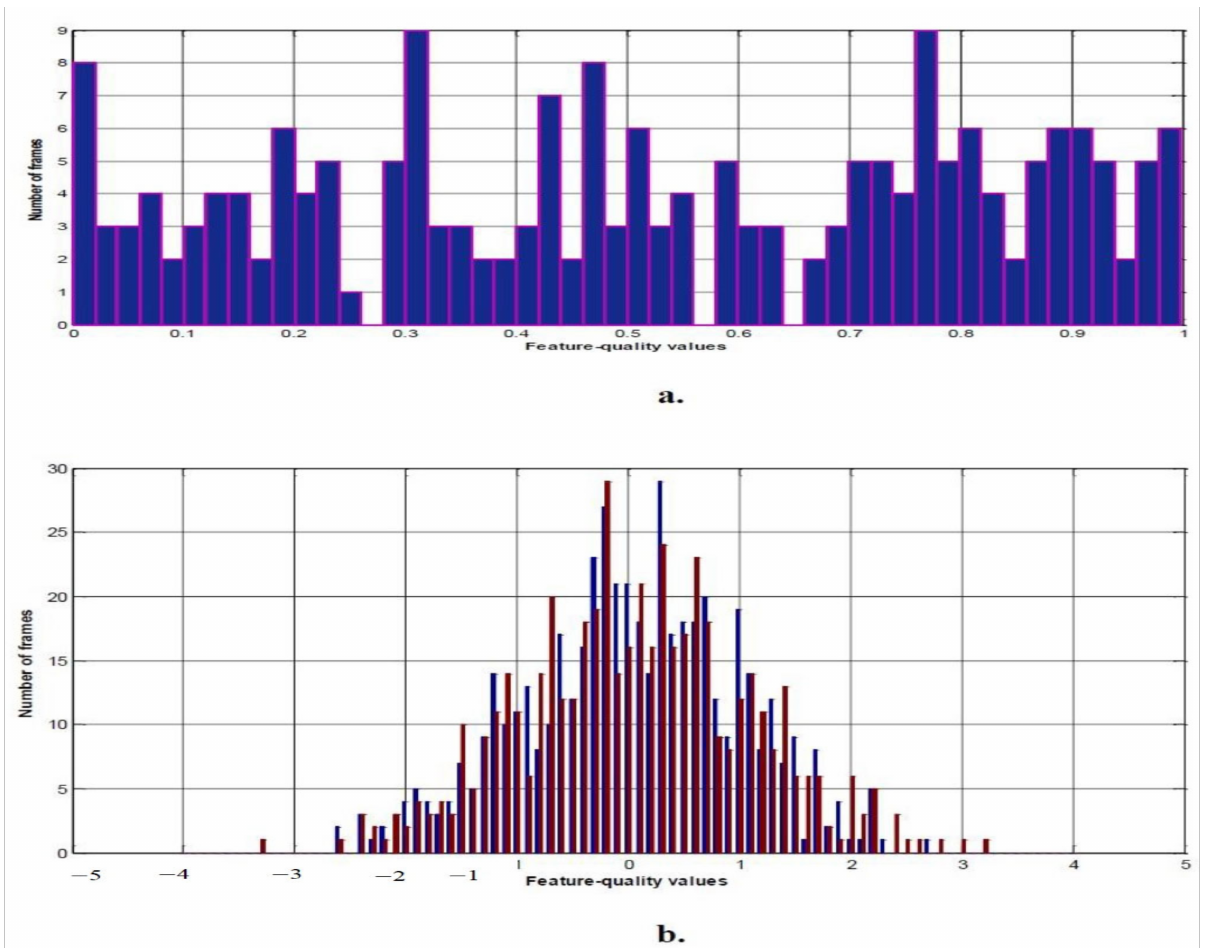
Figure 4. Feature distribution Feature distribution for two dissimilar videos ( a , b ) where some value reaches to zero where as some feature attain value close to one which means high fidelity frame have maximum score where as poor frames have minimum score. Here, x − axis represents feature quality values and y − axis represents number of